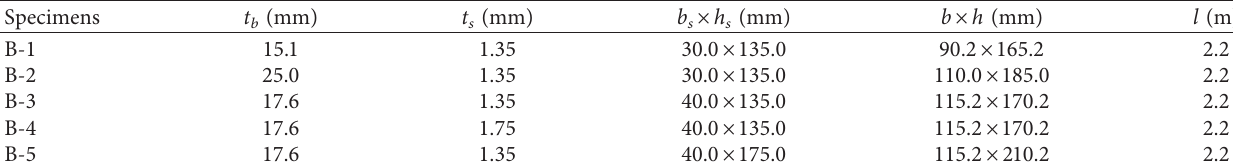
Table 3: Parameters of specimens.